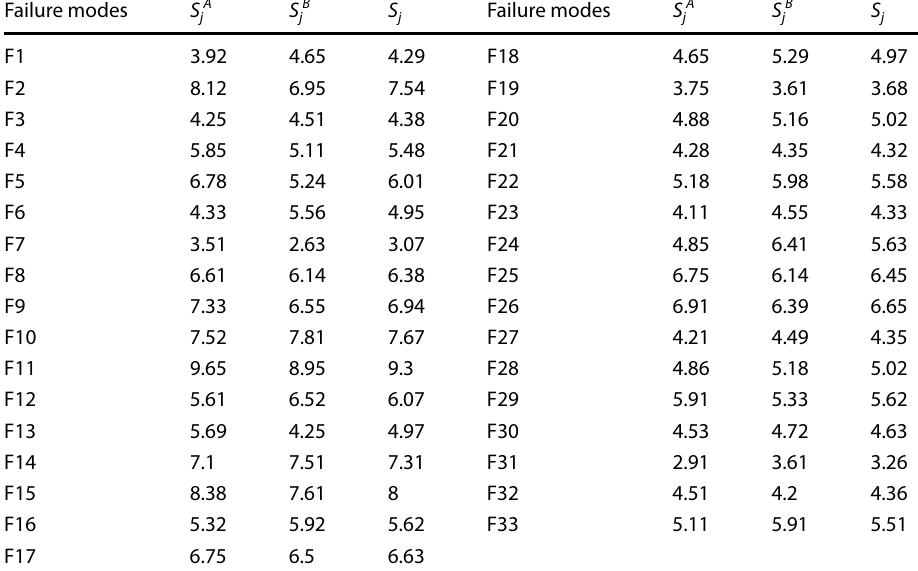
Table 3 Severity number of failure modes